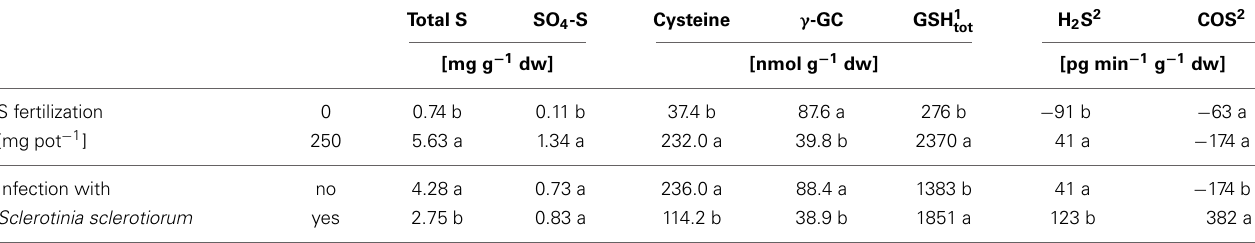
Table 3 | Impact of S nutrition and fungal infection with Sclerotinia sclerotiorum on the S status, S-containing metabolites and the release of gaseous S compounds from Brassica napus (variety Heros ) at stem elongation (data derived from Bloem et al.,